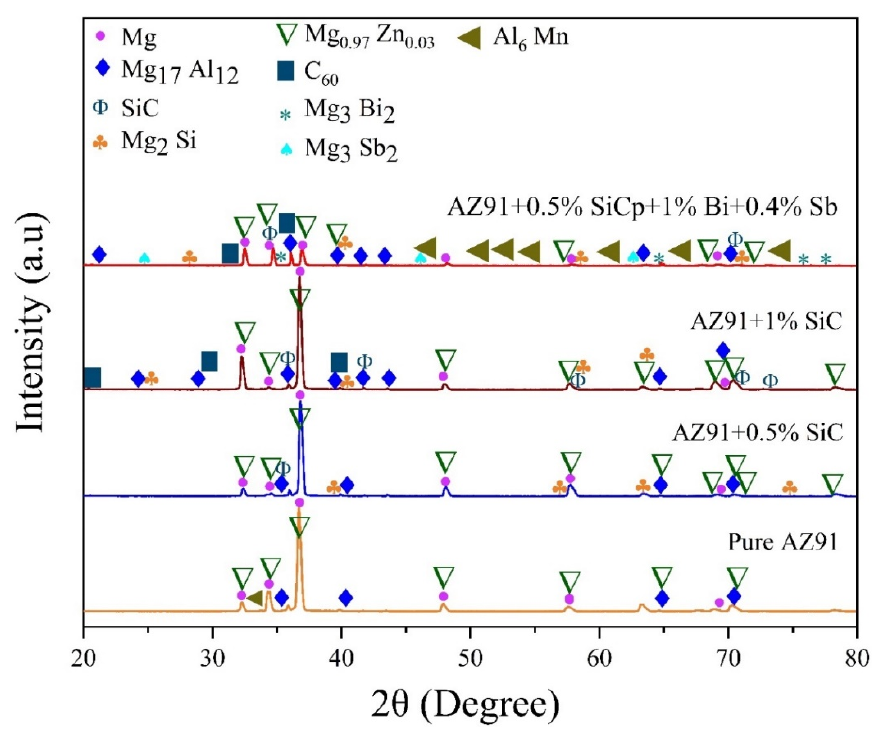
Figure 7. XRD pattern of as-cast AZ91 and AZ91/ β -SiCp/Bi/Sb composites. Table 7. Major intermetallic phases with quantitative values for pure AZ91 and reinforced AZ91 composites. Alloy